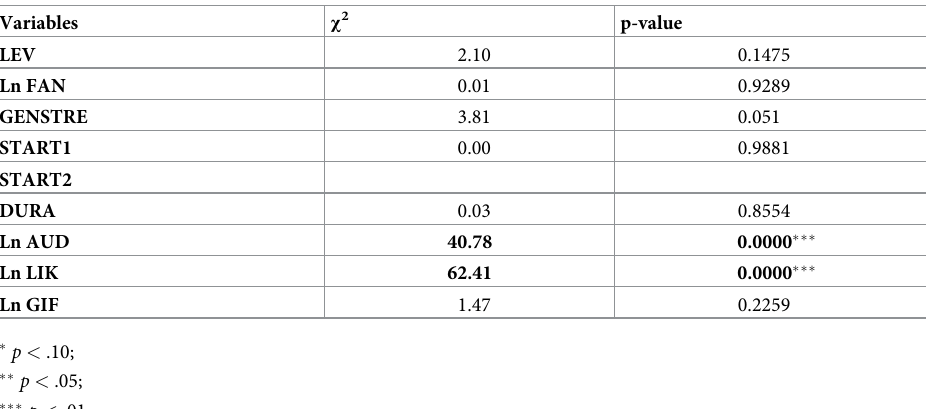
Table 8. Sub-group coefficient